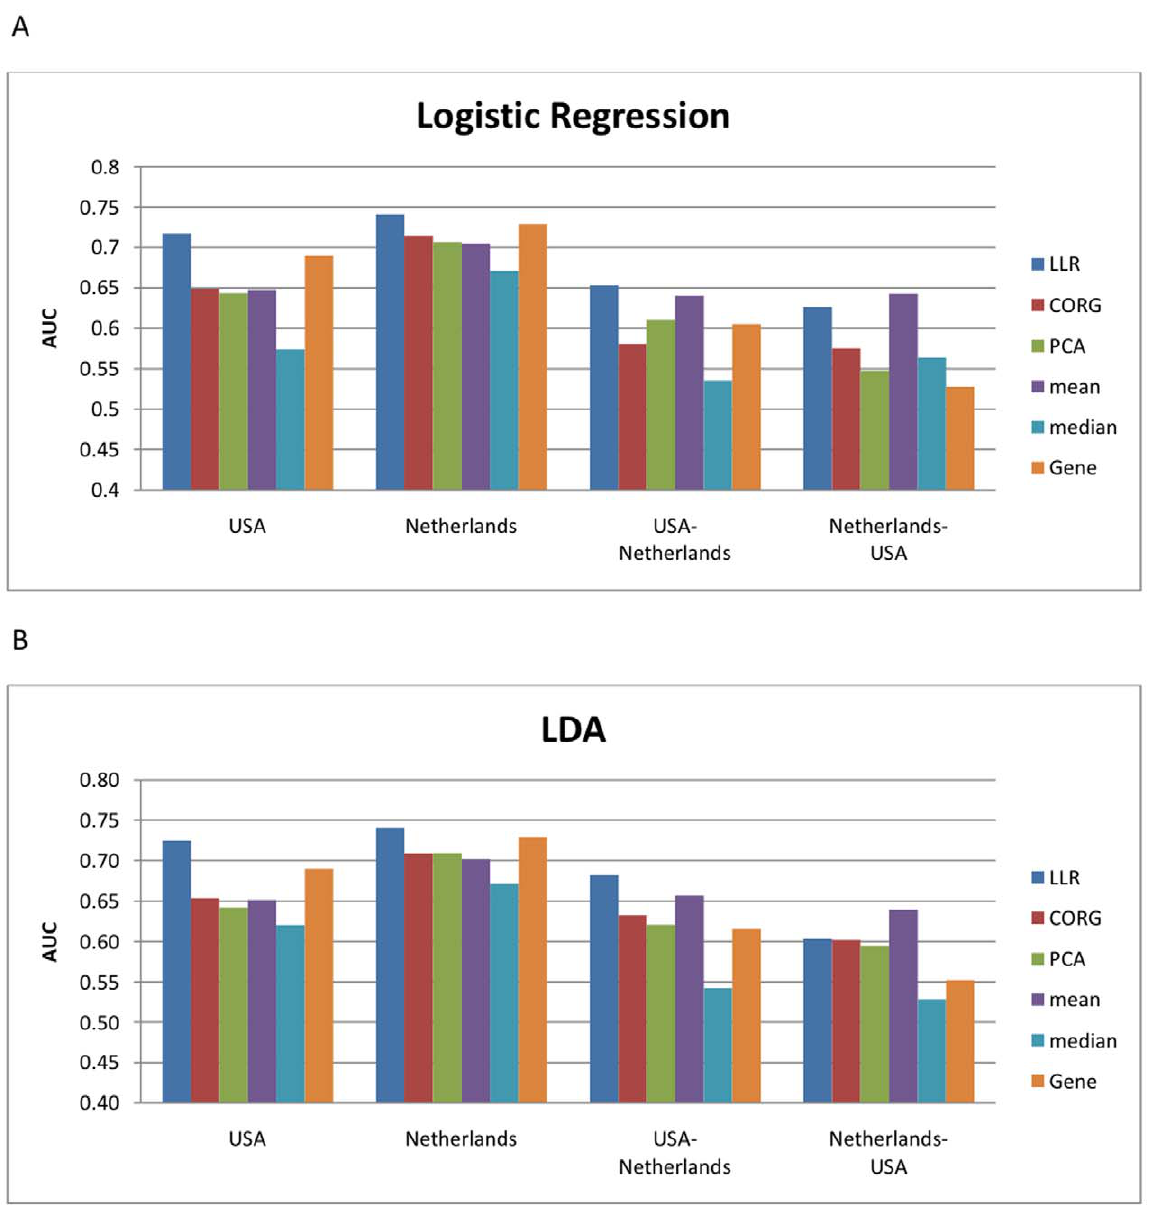
Figure 5. Performance of different classification methods. The bar charts show the average AUCs for different classification methods. Five pathway-based methods that use distinct pathway activity inference schemes (LLR, CORG, PCA, mean, and median) and a gene-based method were compared. (A) Classifiers were constructed based on logistic regression. Results of within-dataset experiments based on the USA and Netherlands datasets are shown in the two charts on the left. The two charts on the right show the results of the cross-dataset experiments. (B) The performance of different classification methods based on LDA (linear discriminant analysis).